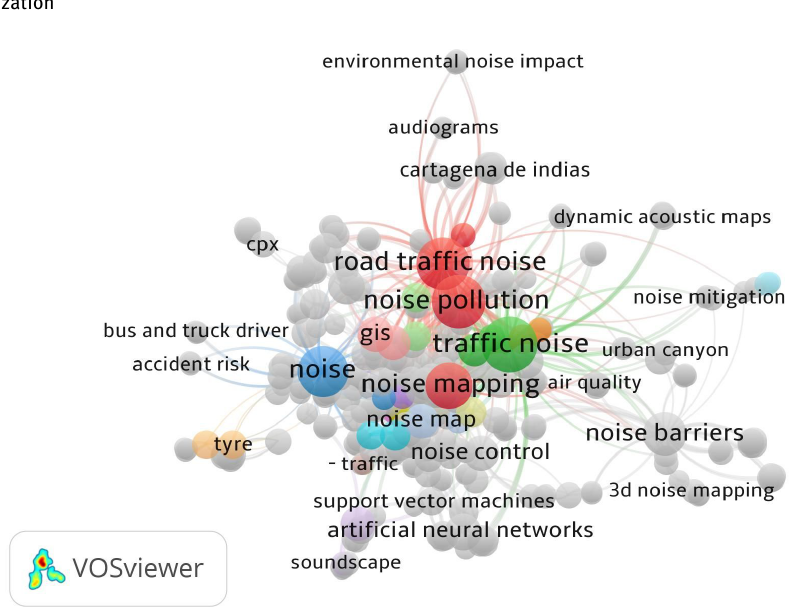
Figure 4: Network visualization association with strength